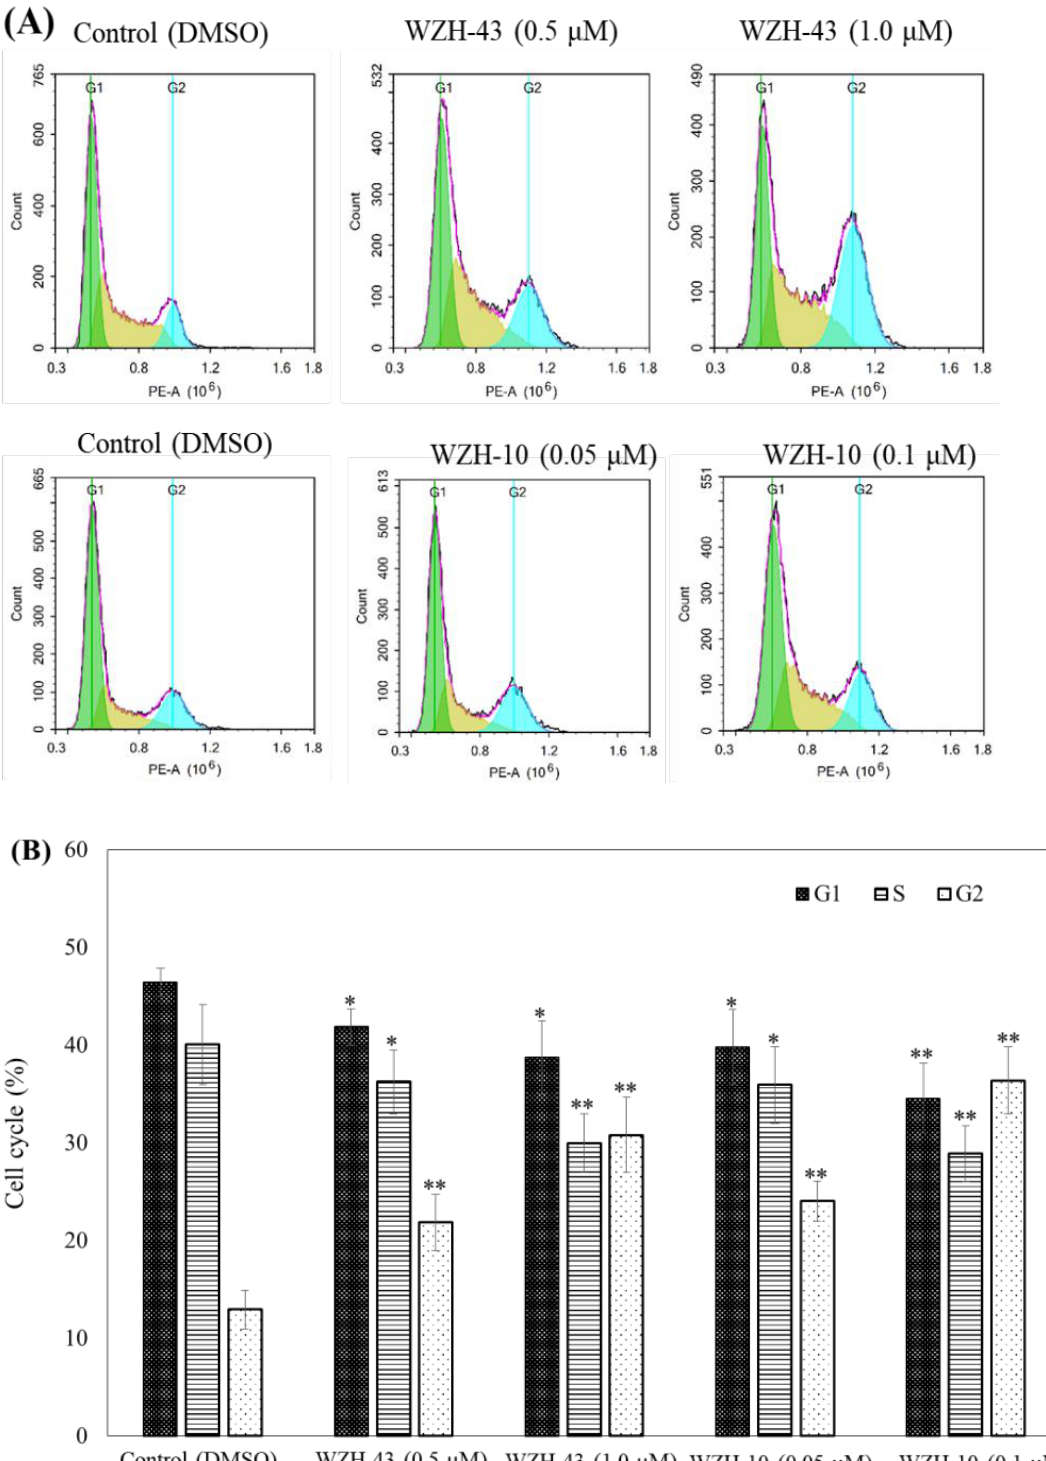
Figure 3. Cell cycle analysis of PC3 cells treated with different concentrations of the two prenylated chalcones for 48 h. ( A ) Cell cycle changes induced by the two prenylated chalcones by flow cytometry. ( B ) The quantification of the results in ( A ). The G1, G2, and S percentages were related to total diploid cells. Results are presented as mean ± SEM. * p < 0.05, ** p < 0.01 ( n = 3) compared with the control.